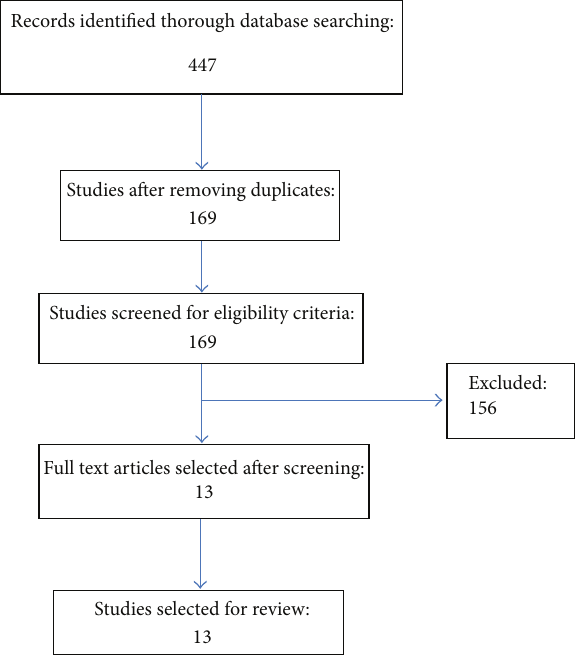
Figure 1: Showing the literature search